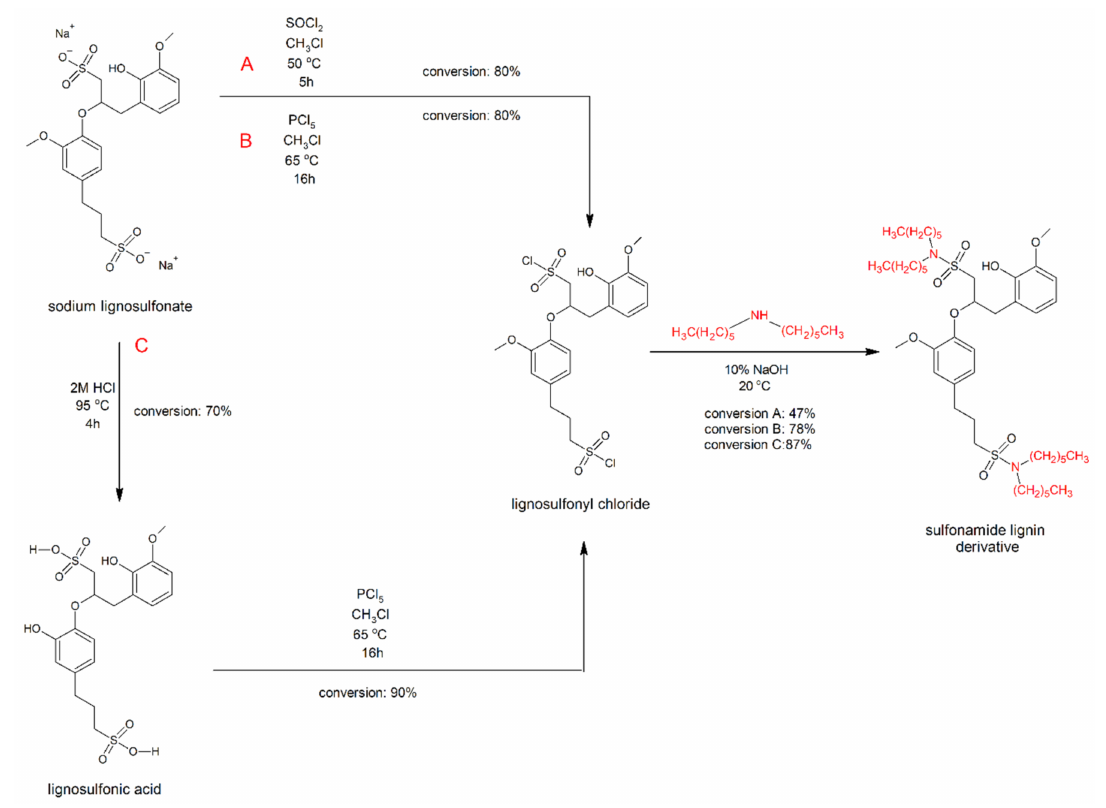
Figure 1. Schematic presentation of the synthetic routes leading to